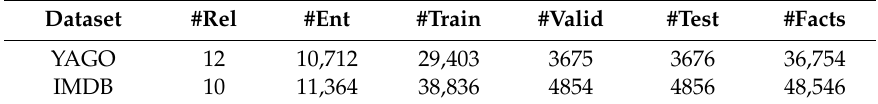
Table 1. YAGO (Yet Another Great Ontology) and IMDB (Internet Movie Database) datasets statistics.